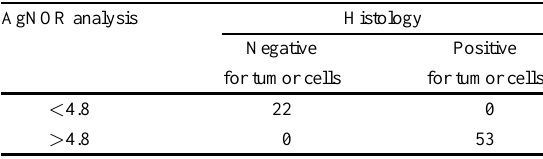
Sensitivity and specificity of AgNOR-analysis versus histology in oral lesions ( n = 75 cases) AgNOR analysis Histology